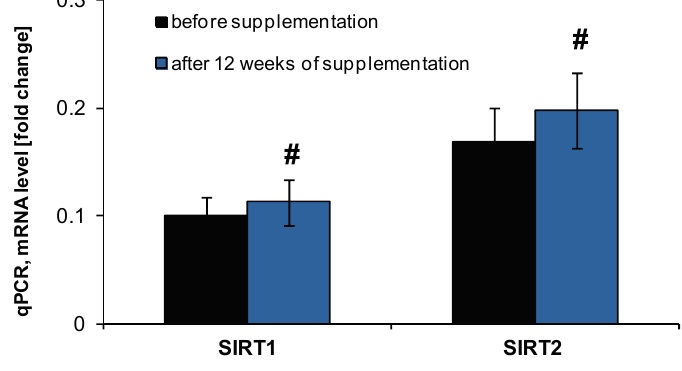
Figure 3. Expression of histone deacetylases (SIRT1 and SIRT2) in peripheral blood mononuclear cells isolated from blood of volunteers taking NucleVital ® Q10 Complex. # indicates statistically significant differences ( p <